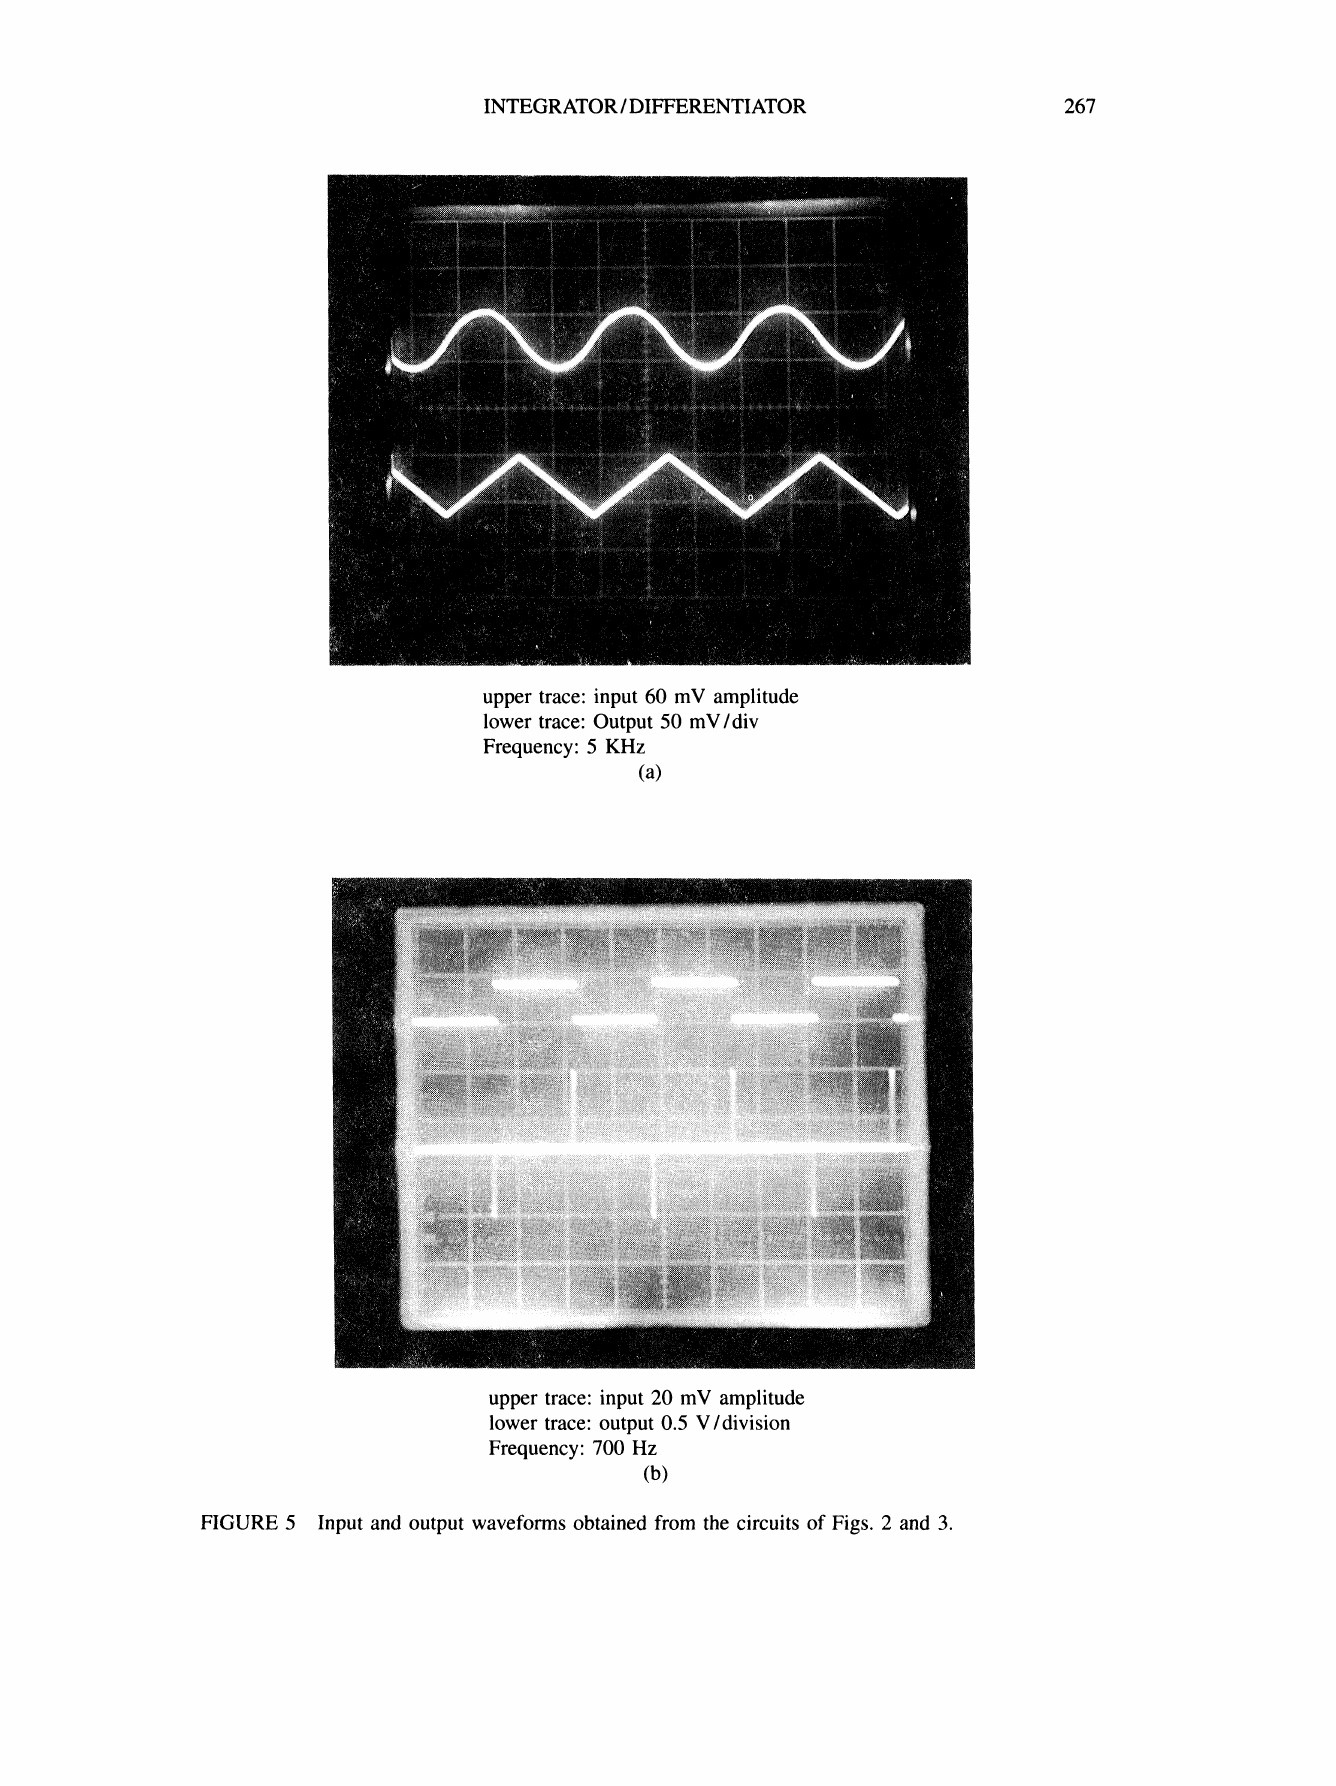
FIGURE 5 Input and output waveforms obtained from the circuits of Figs. 2 and